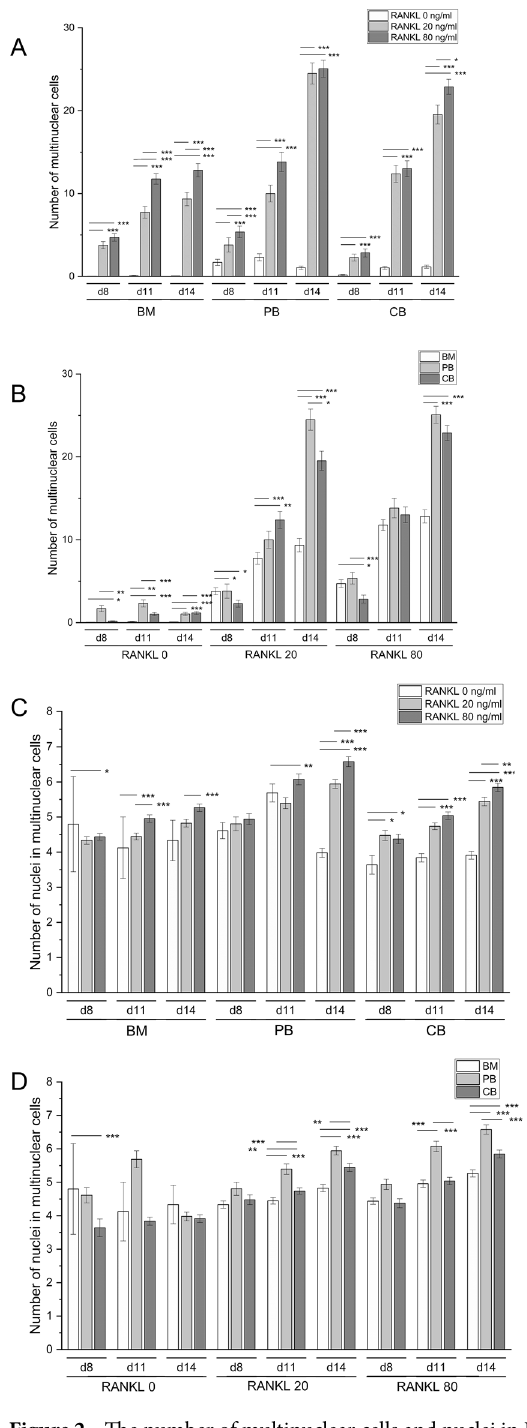
Figure 2. The number of multinuclear cells and nuclei in BM, PB and CB cultures. A&B. The number of multinuclear cells at different time points during the cell culture. The data in graphs A and B is same but presented in regard to cell source ( A ) or RANKL concentration ( B ) for easier comparison between the samples. ( C ) The number of nuclei in multinuclear cells. The data in graphs is pooled from 4 patients per culture type and shown as mean ± SEM. * p < 0.05, ** p < 0.01, *** p <